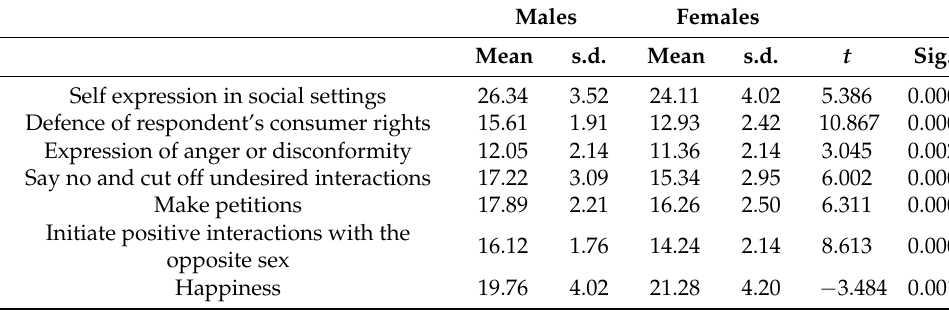
Table 1. Social ability scores and happiness by